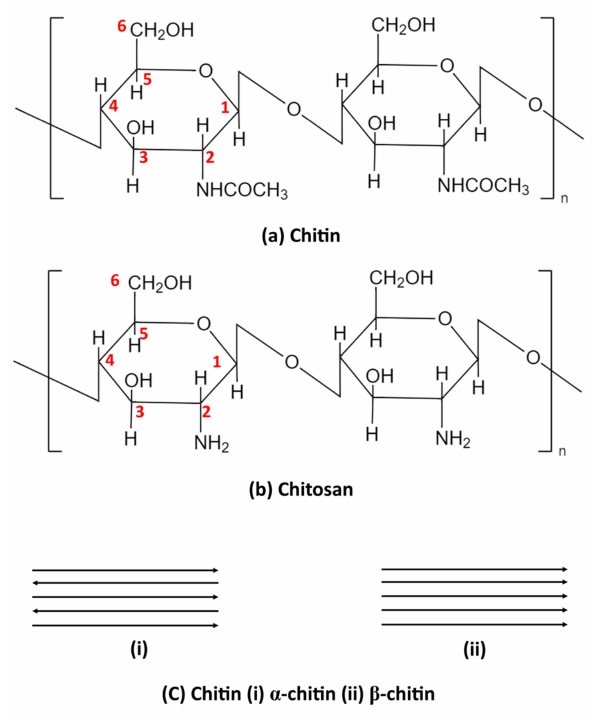
Figure 1. Chemical structure of ( a ) chitin and ( b ) CS ( c ) α - and β